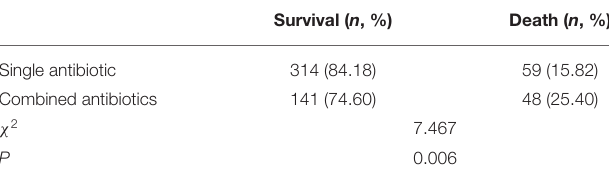
TABLE 2 | Comparison of mortality of patients with blood stream infection treated with single and combined